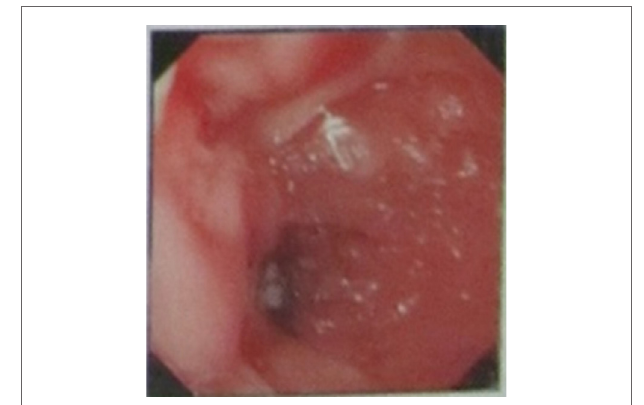
FIgURe 1 | Representative picture showing results from three independent endoscopic evaluations of the intestine of the patient obtained at different times before he was started on antibiotic therapy . There was no opportunity for further evaluations during